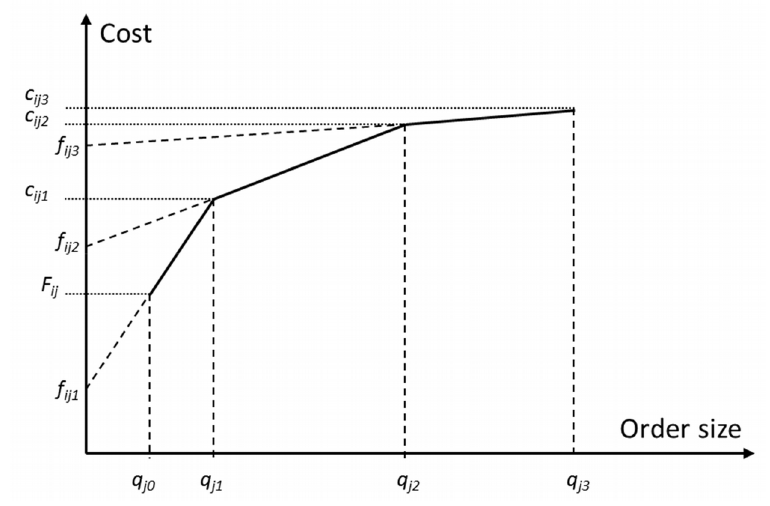
Figure 1. Cost of an order as a function of its